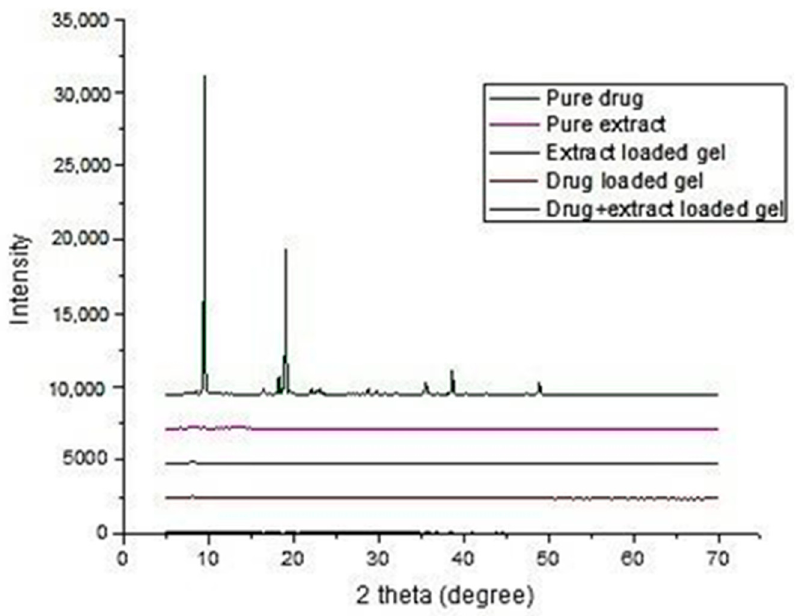
Figure 4. Graph between intensity and 2 θ ° of all formulations.